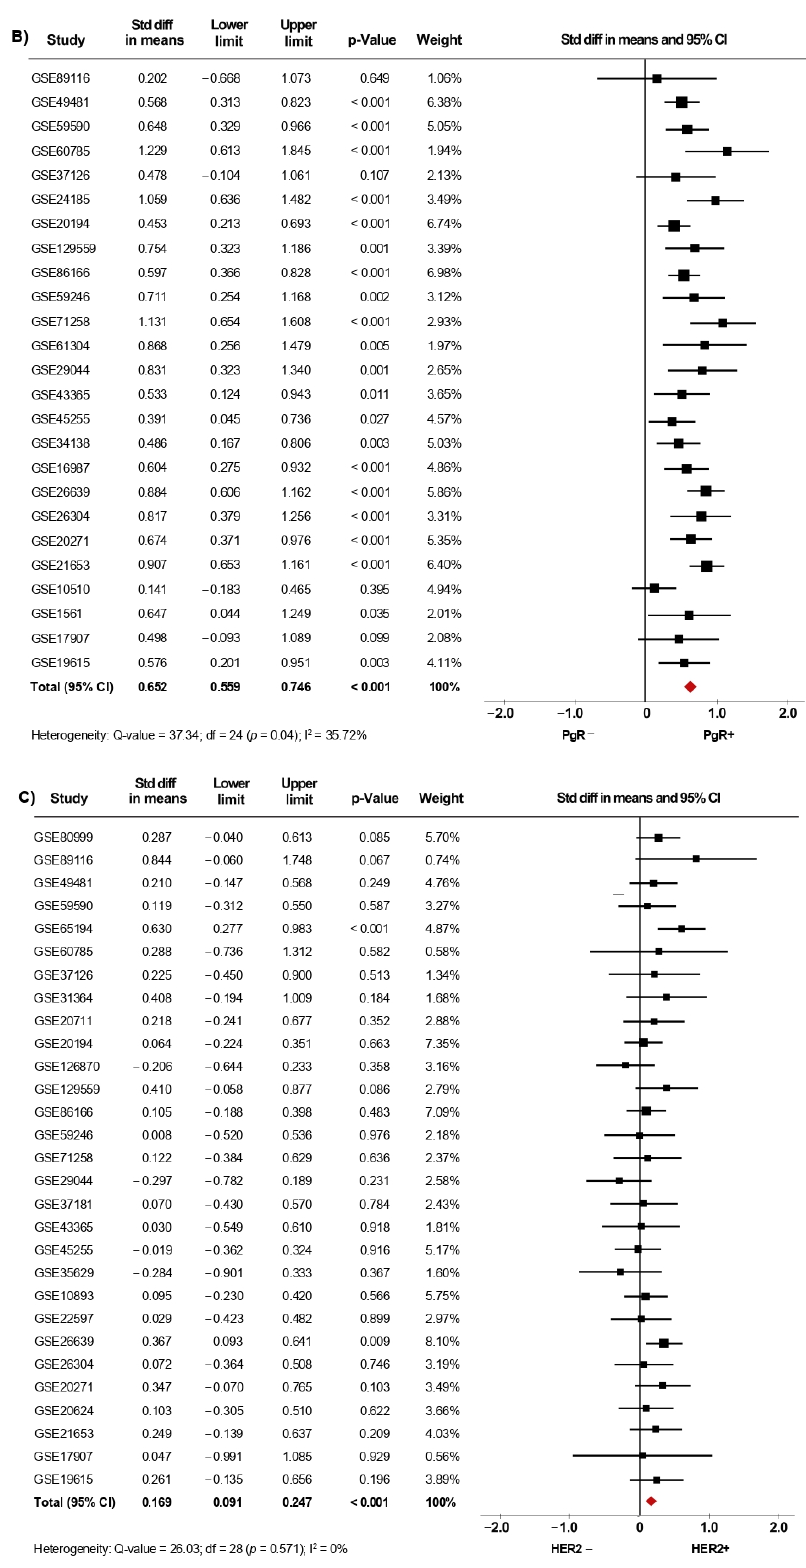
Figure 3. AR mRNA expression is higher in BC patients expressing either ER, PgR and HER2. Results after sensitivity analyses. Forest plots of SMD showing AR mRNA levels associated with ER ( A ), PgR ( B ), and HER2 status ( C ). The squares represent the SMD for each dataset. The horizontal line crossing the square represents the 95% CI. The red diamonds represent the estimated overall